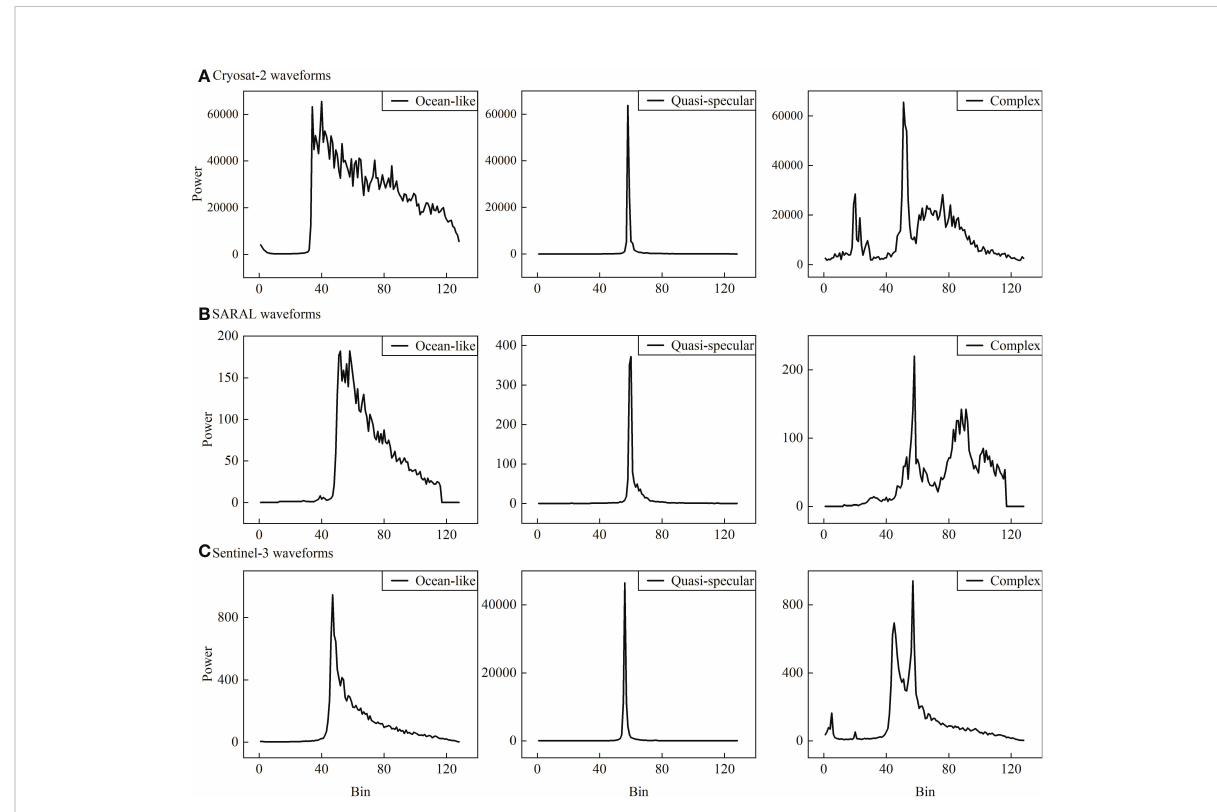
FIGURE 3 Three coastal waveforms of Cryosat-2, SARAL and Sentinel-3 altimeters in this study. (A) Cryosat-2, (B) SARAL, (C)